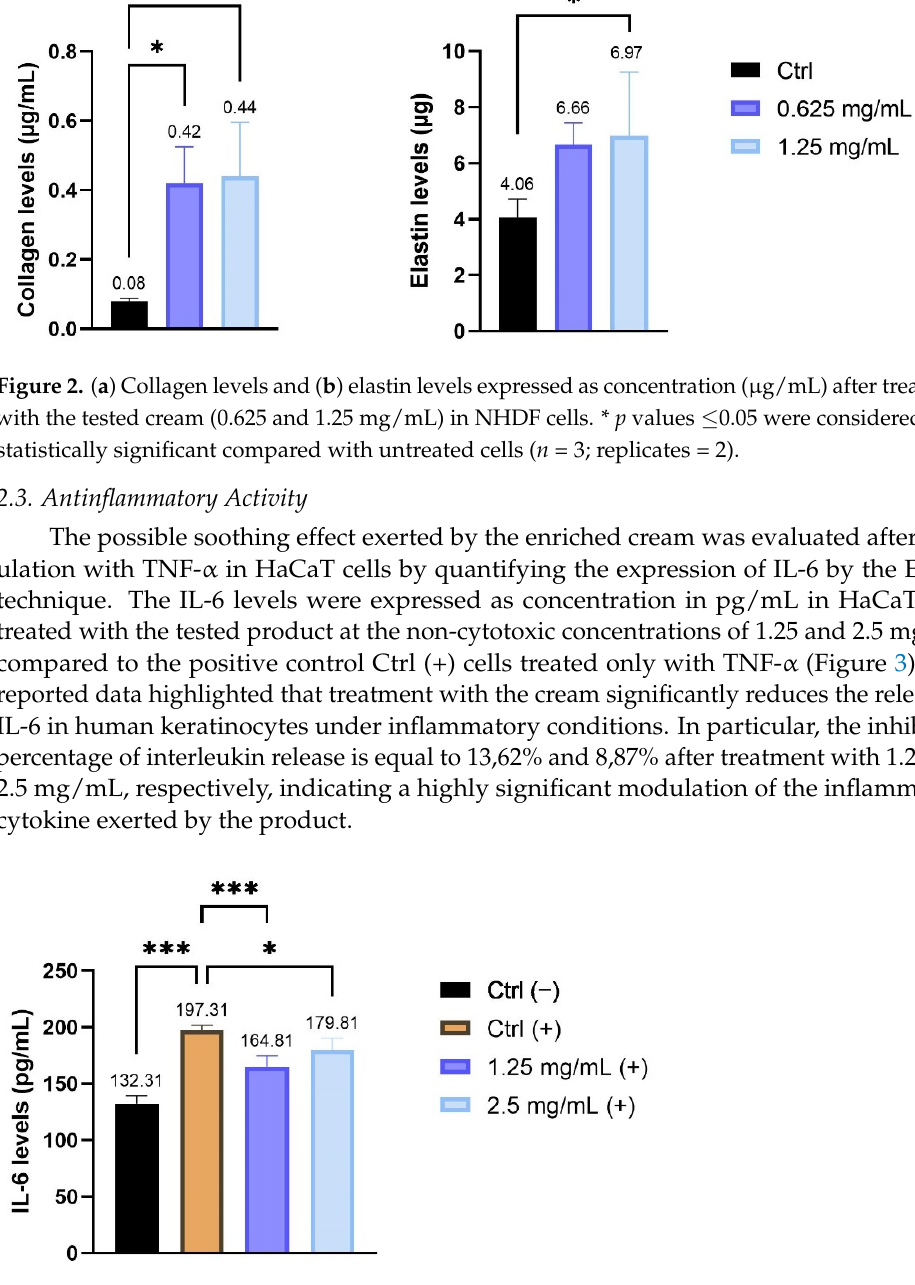
Figure 3. Quantitative analysis of IL-6 levels (pg/mL) after treatment with the cosmetic cream at the concentrations of 1.25 and 2.5 mg/mL and stimulation with TNF- α ; Ctrl ( − ): untreated cells; Ctrl (+): cells treated only with TNF- α . * p values ≤ 0.05 and *** p values ≤ 0.001 were considered to be statistically significant compared with respective controls ( n = 2; replicates = 2).